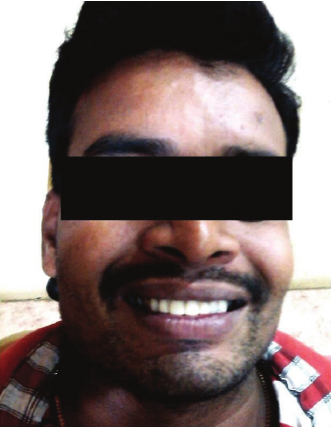
Figure 6: Clinical photograph—after